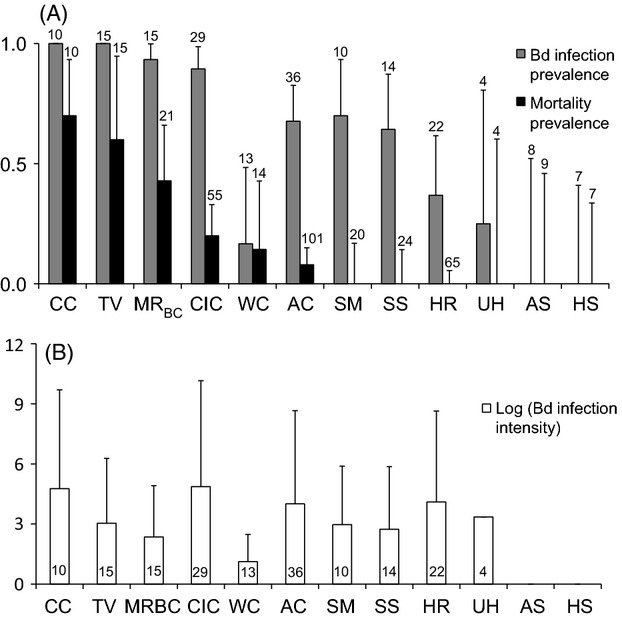
Lithobates yavapaiensis winter disease dynamics for 12 natural populations sampled in Arizona, USA. (A) Observed prevalence of winter Batrachochytrium dendrobatidis (Bd) infection (gray bars) and mortality (black bars) by locality, with 95% Clopper–Pearson binomial confidence intervals. Sample sizes are shown above error bars. (B) Logarithm of mean population winter Bd infection intensity, measured as the average number of genome equivalents recovered per animal (+SD). Sample sizes are shown inside of each bar. Locality abbreviations are as follows: AS, Aliso Spring; AC, Aravaipa Canyon; CC, Cottonwood Canyon; CIC, Cienega Creek; HS, House Spring; HR, Hassayampa River; MRBC, Muleshoe Ranch, Bass Canyon subpopulation; SM, Santa Maria River; SS, Seven Springs; TV, Tanque Verde Canyon; WC, Willow Creek; UH, Upper Hassayampa. MR Hot Springs and Secret Spring are not shown due to geothermally driven disease dynamics; see Savage et al. (2011).